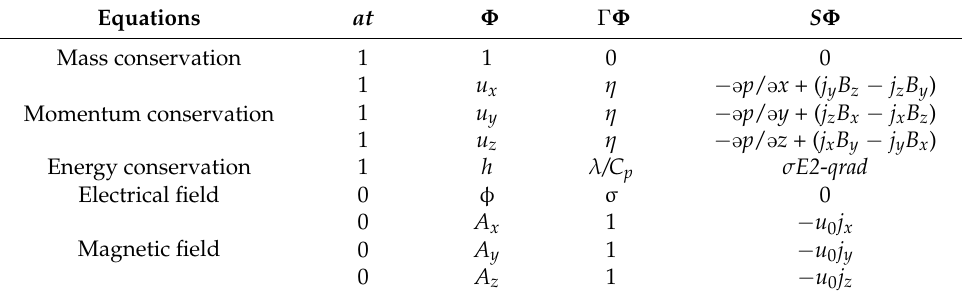
Table 1. Magnetohydrodynamics control equation.